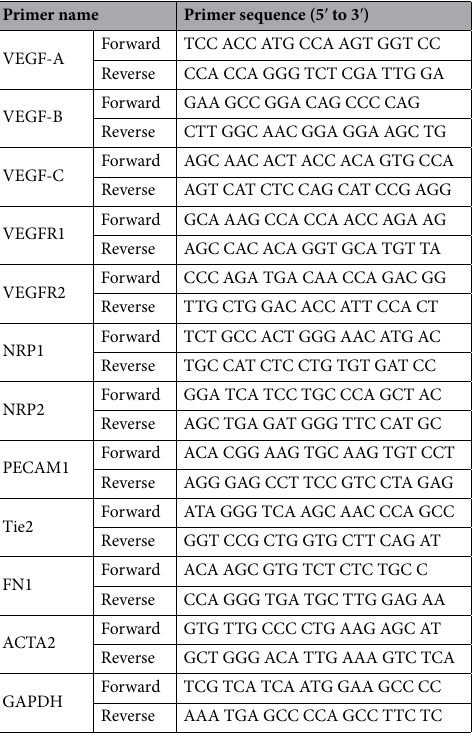
Table 1. Primer list for quantitative real-time polymerase chain reaction. VEGF vascular endothelial growth factor, VEGFR vascular endothelial growth factor receptor, NRP neuropilin, PECAM platelet endothelial cell adhesion molecule, Tie tyrosine kinase with Ig-like loops and epidermal growth factor homology domains, FN fibronectin, ACTA2 α-smooth muscle actin, GAPDH glyceraldehyde 3-phosphate